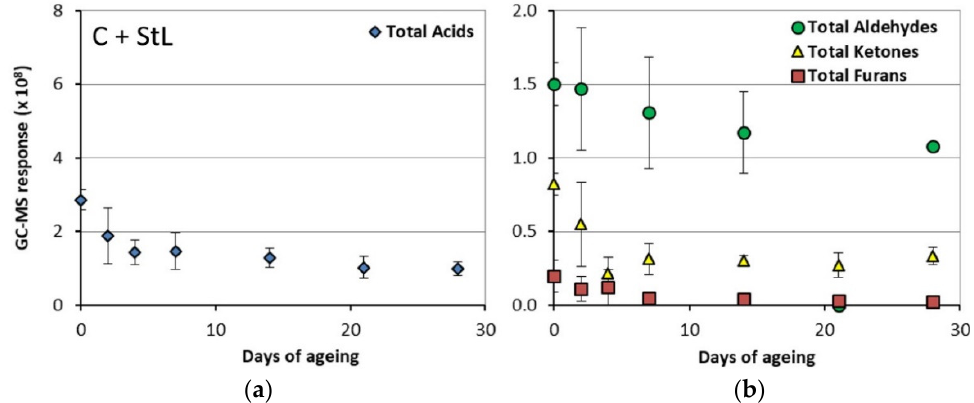
Figure 12. The evolution of the basic chemical groups of VOCs’ emission by cotton mock-ups im- pregnated with refined linseed oil upon ageing: ( a ) acids; ( b ) aldehydes, ketones, and